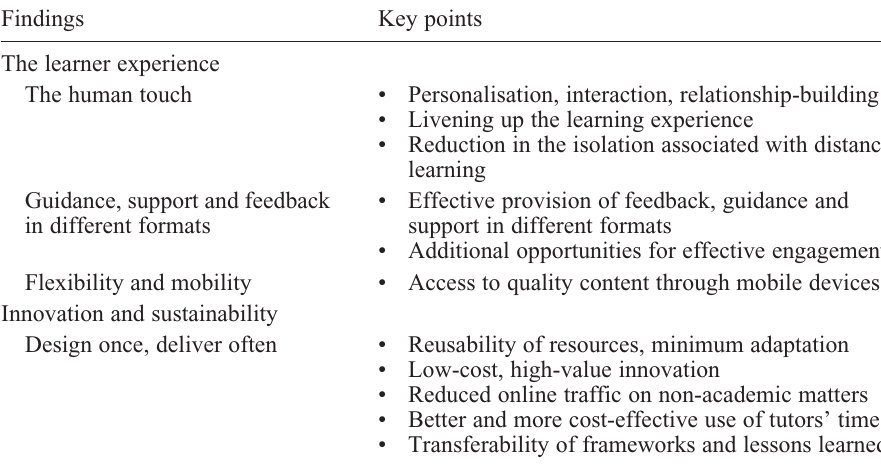
Table 5. Summary of key research findings.